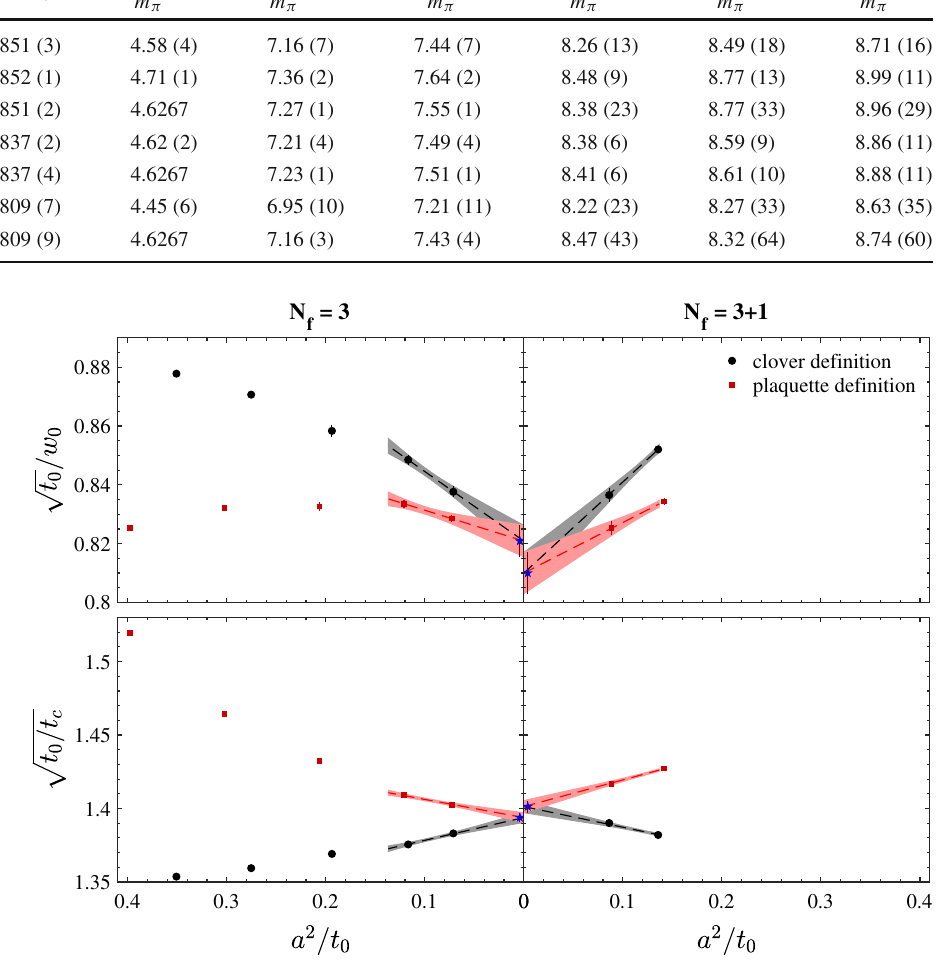
Table 8 Dimensionless quantities on various ensembles, the second row values for ensembles A2 and B are shifted to the correct tuning points φ 4 and φ 5 , using the strategy described in Sect. 3.3, Eq. (3.20). Note, there is no error for the shifted m D / m π ratio, since it is given Ens.